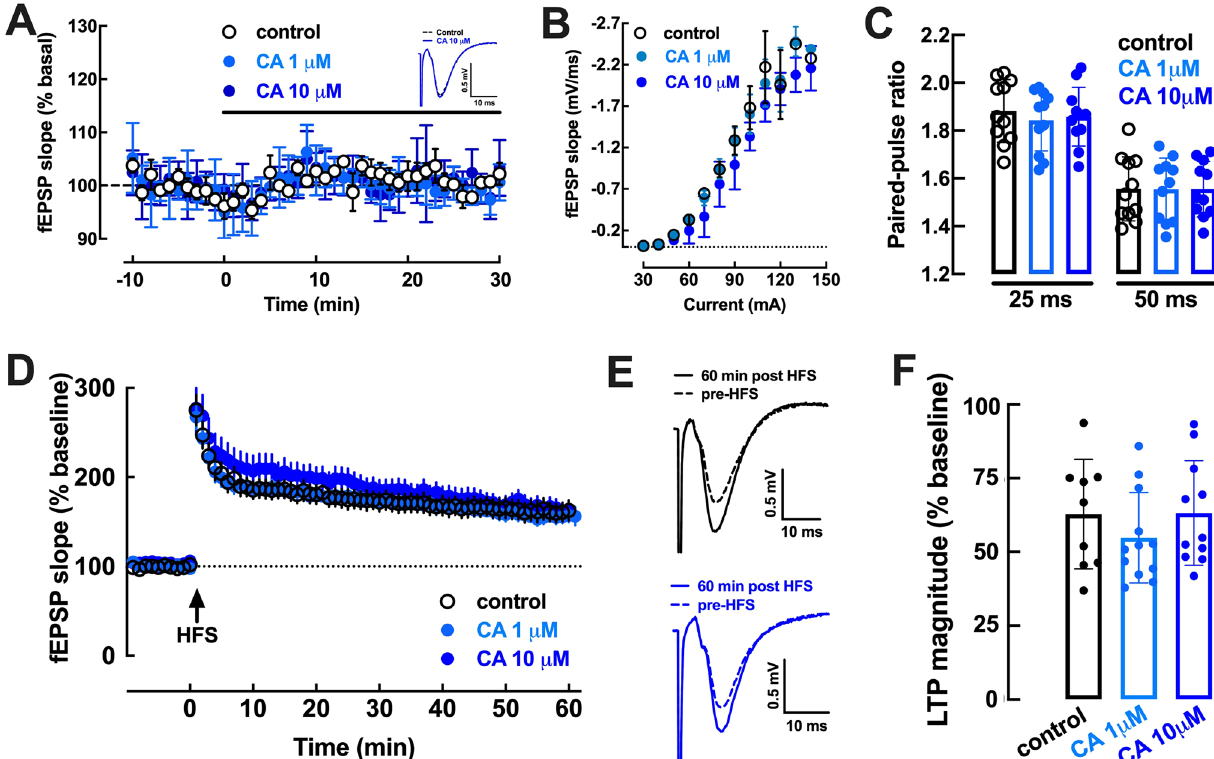
Figure 1. The chlorogenic acid 3-(3,4-dihydroxycinnamoyl)quinic acid (CA, 1 or 10 µM) did not affect either basal synaptic transmission or synaptic plasticity. CA (1 µM, light blue symbols or 10 µM, dark blue symbols) did not alter basal synaptic transmission ( A ), measured as the descending slope of field excitatory postsynaptic potentials (fEPSP) recorded extracellularly in the stratum radiatum of the CA1 area upon stimulation of the afferent Schaffer collaterals, illustrated as inserts in panel A. Likewise, CA (1 or 10 µM) did not modify the input–output responses ( B ) or the paired-pulse facilitation ratio, i.e. the ratio of the fEPSP slopes evoked by two consecutive pulses (ratio of P2/P1) with inter-pulse intervals of 25 or 50 ms ( C ). The average time course experiments of LTP induction ( D ), i.e. the variation of fEPSP slope over time upon induction of LTP with a high-frequency stimulation train (HFS: one train of 100 pulses of delivered at 100 Hz) in hippocampal slices untreated (control, black symbols) or treated with CA (1 or 10 µM), revealed that LTP magnitude was not affected by CA ( F ). ( E ) Representative fEPSP recorded in ACSF (control conditions, upper row) and in the presence of 10 µM CA (lower row) before (dashed traces) and 60 min after the HFS (filled traces). Data are mean ± S.E.M. of 6–12